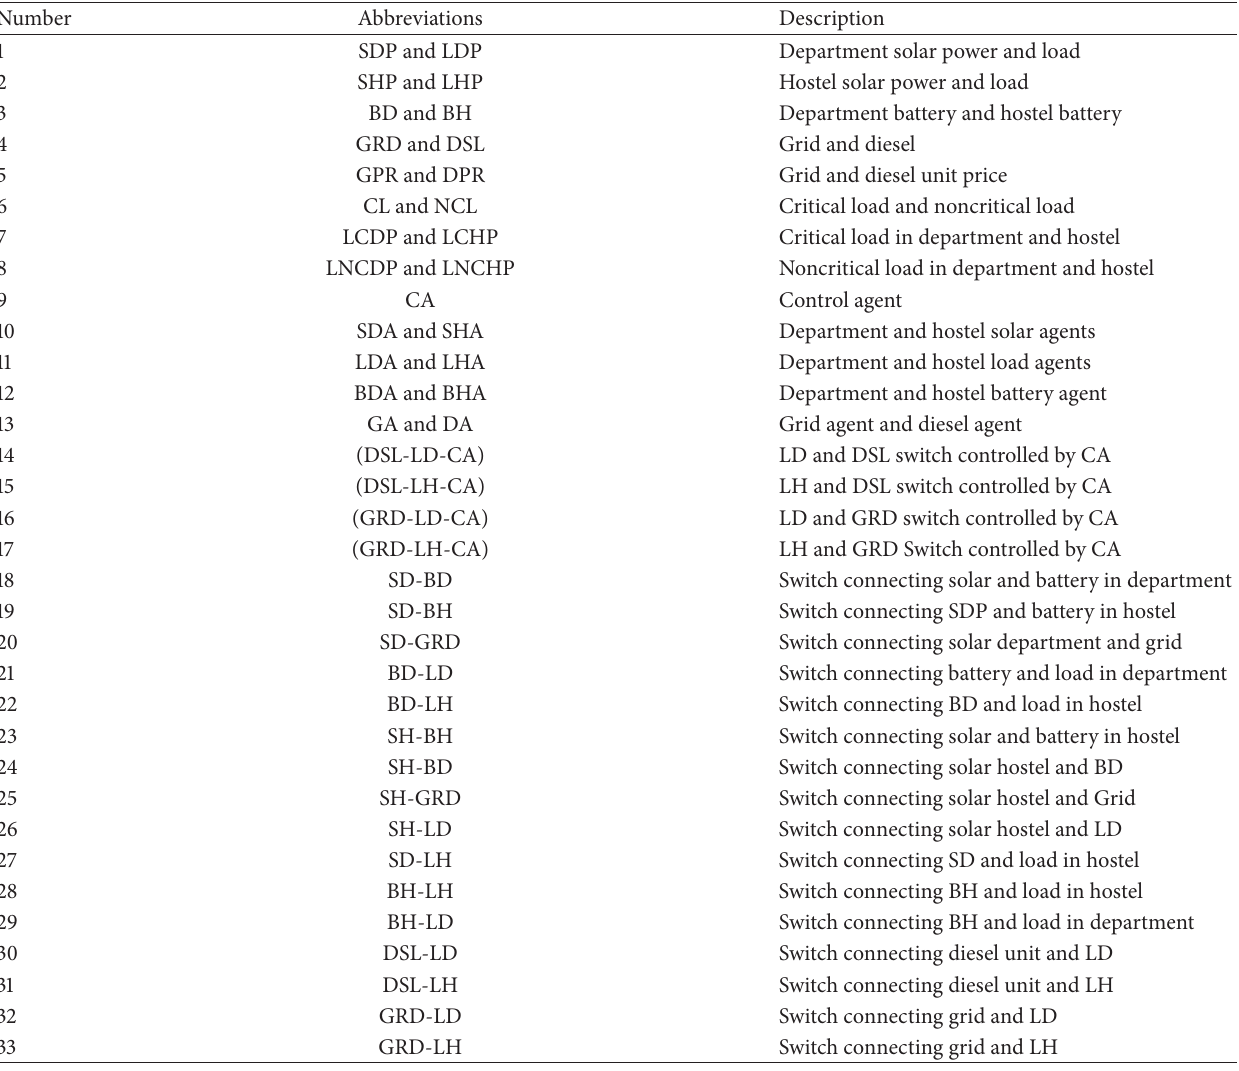
Table 1: Device description.